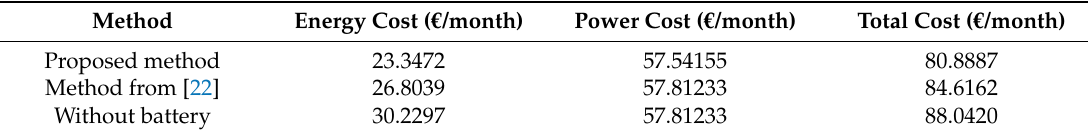
Table 4. Cost comparison.